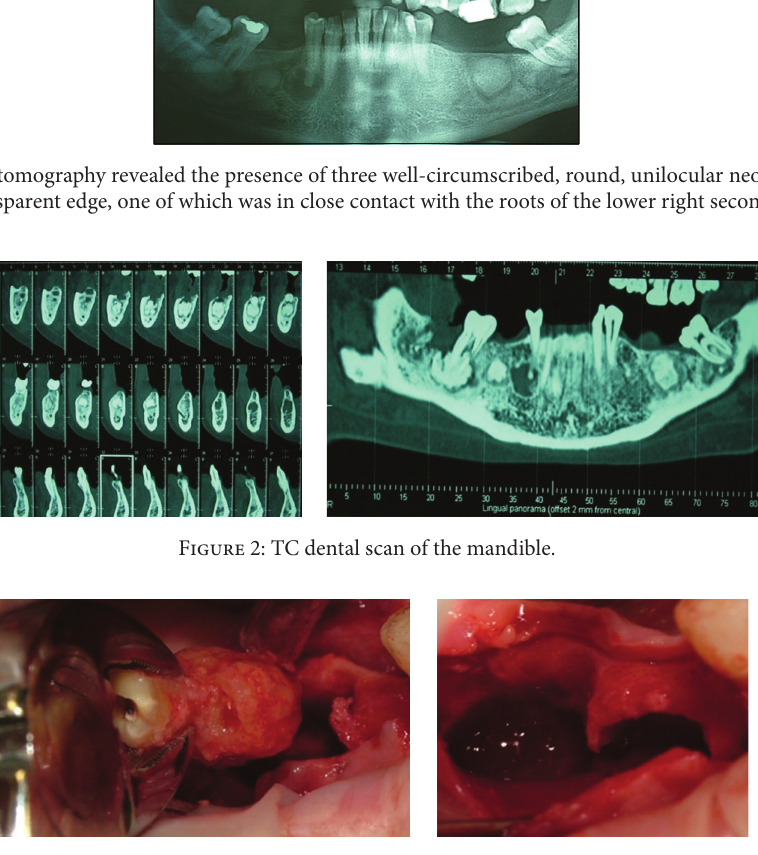
Figure 3: The surgical treatment included the full enucleation of the lesion on site 4.7 with the annexed dental element on the right jaw and the lesion corresponding to the edentulous area